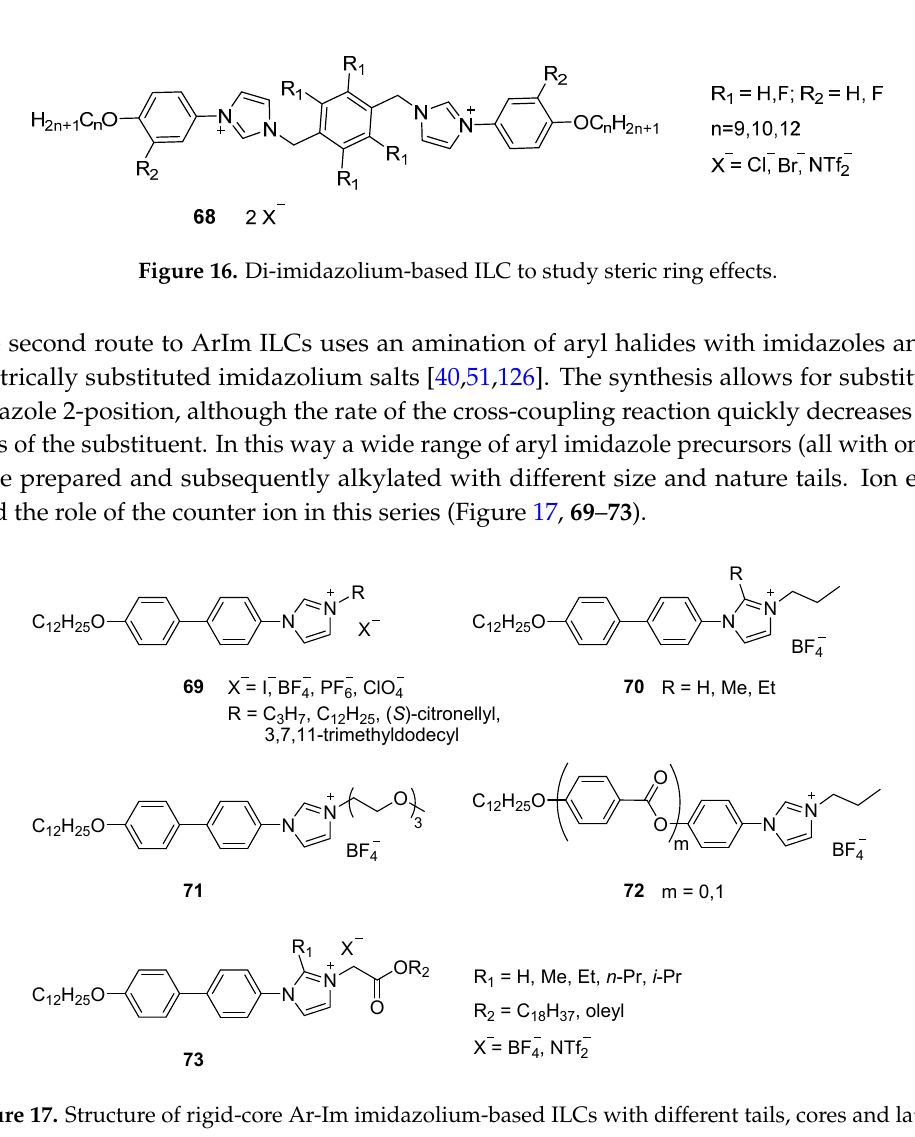
Figure 17. Structure of rigid-core Ar-Im imidazolium-based ILCs with different tails, cores and lateral substituents to tailor the thermal properties of the mesogens. In this class of ILCs, the cation is directly attached to an aromatic core which gives the molecules the structure and characteristics more in line with traditional mesogens.